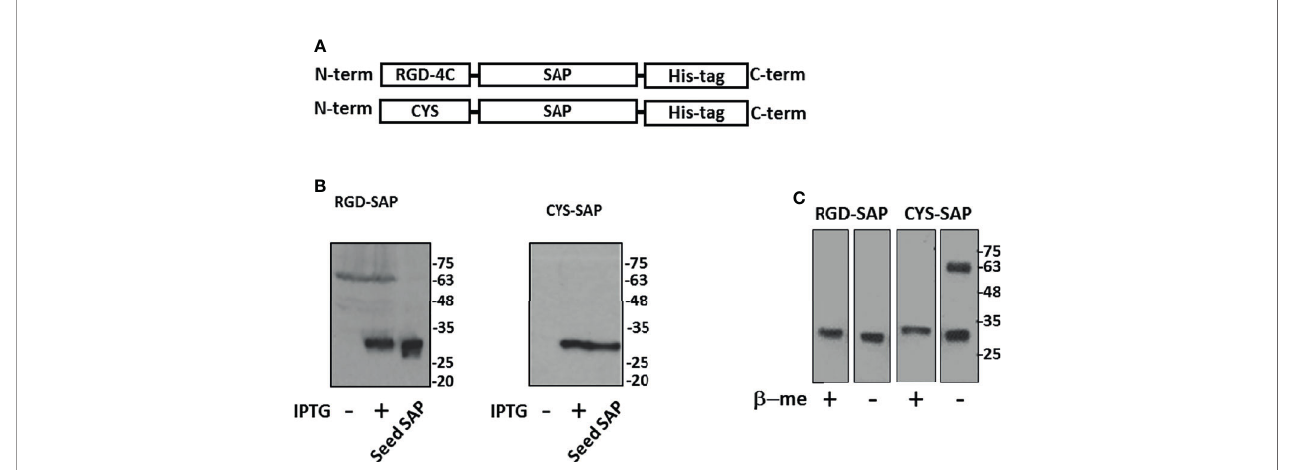
FIGURE 1 | Design, expression and puri fi cation of RGD-SAP and CYS-SAP recombinant proteins. (A) Schematic representation of RGD-SAP and CYS-SAP recombinant proteins. The RGD (ACDCRGDCFCG) targeting and CYS (CGGSGG) non-targeting peptides were inserted by genetic recombination at the N-terminus of SAP. A histidine (His)-tag was added at the C-terminus of the two constructs to aid in the puri fi cation of the recombinant proteins. (B) Effect of IPTG on RGD-SAP and CYS-SAP expression in BL21DE3 E.coli cells as determined by western blot using an anti-SAP antibody. IPTG (+) and (-), induced and not induced cells, respectively. Seed-derived SAP (200 ng) was used as positive control for WB analysis. (C) WB analysis of puri fi ed RGD-SAP and CYS-SAP under reducing ( b - mercaproethanol ( b -me) +) or non-reducing ( b -me -) conditions.